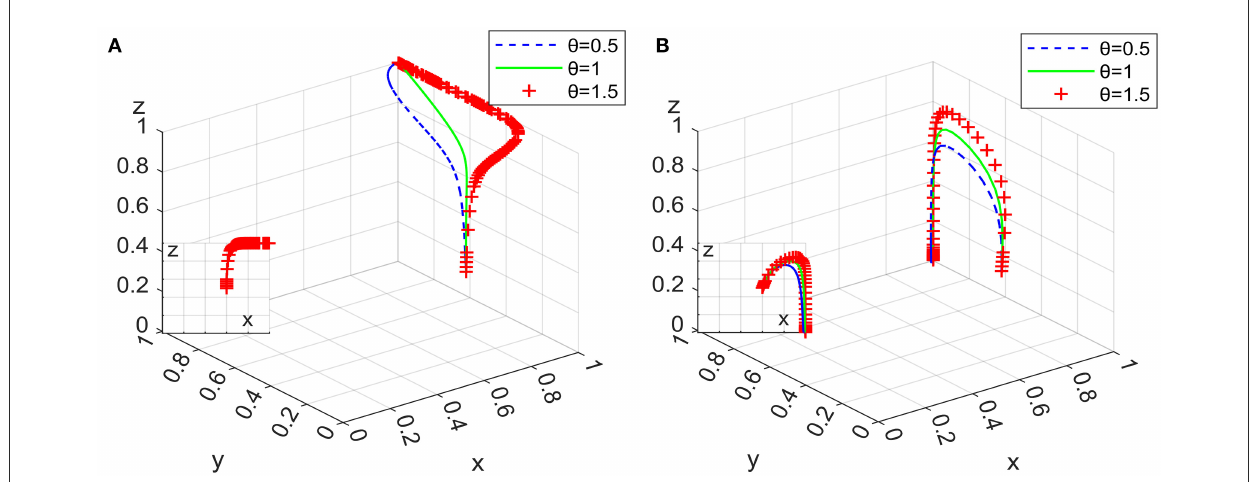
FIGURE11 Impact on punishment intensity in system L (A) and system P (B)